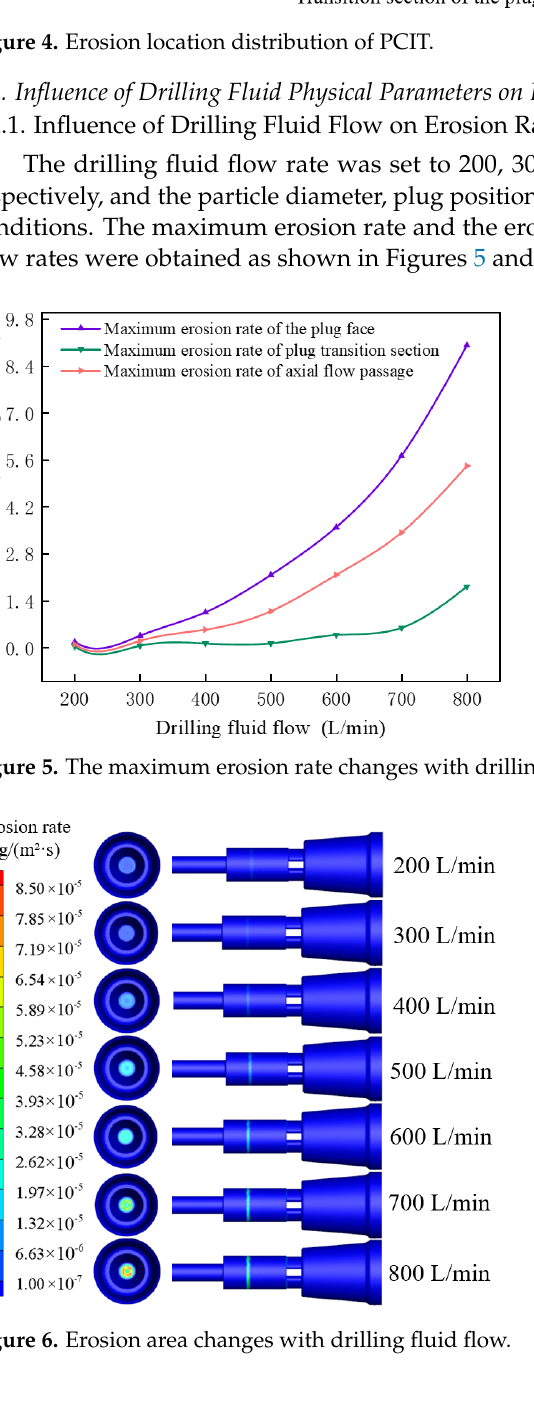
Figure 6. Erosion area changes with drilling fluid